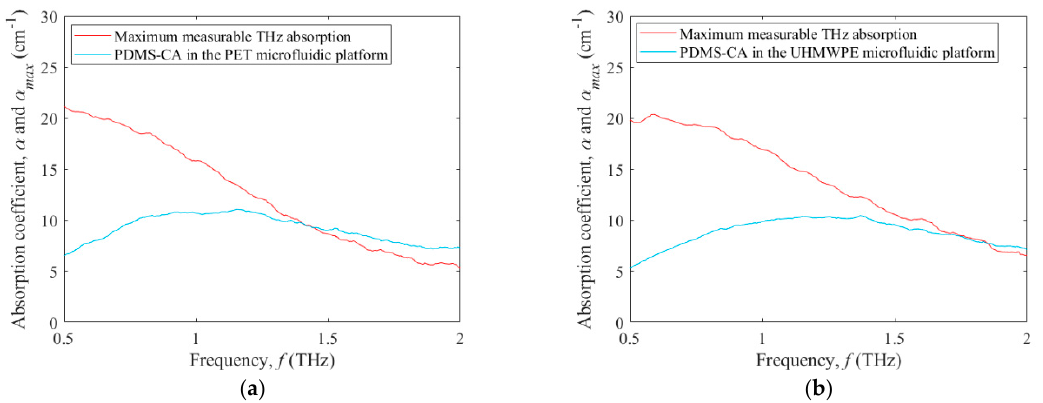
Figure 5. Terahertz absorption coefficient, α , and maximum measurable THz absorption coefficient, α max , versus frequency, f , from 0.5 to 2.0 THz for PDMS-CA as the test fluid. The results are shown for the ( a ) PET microfluidic platform and ( b ) UHMWPE microfluidic platform.